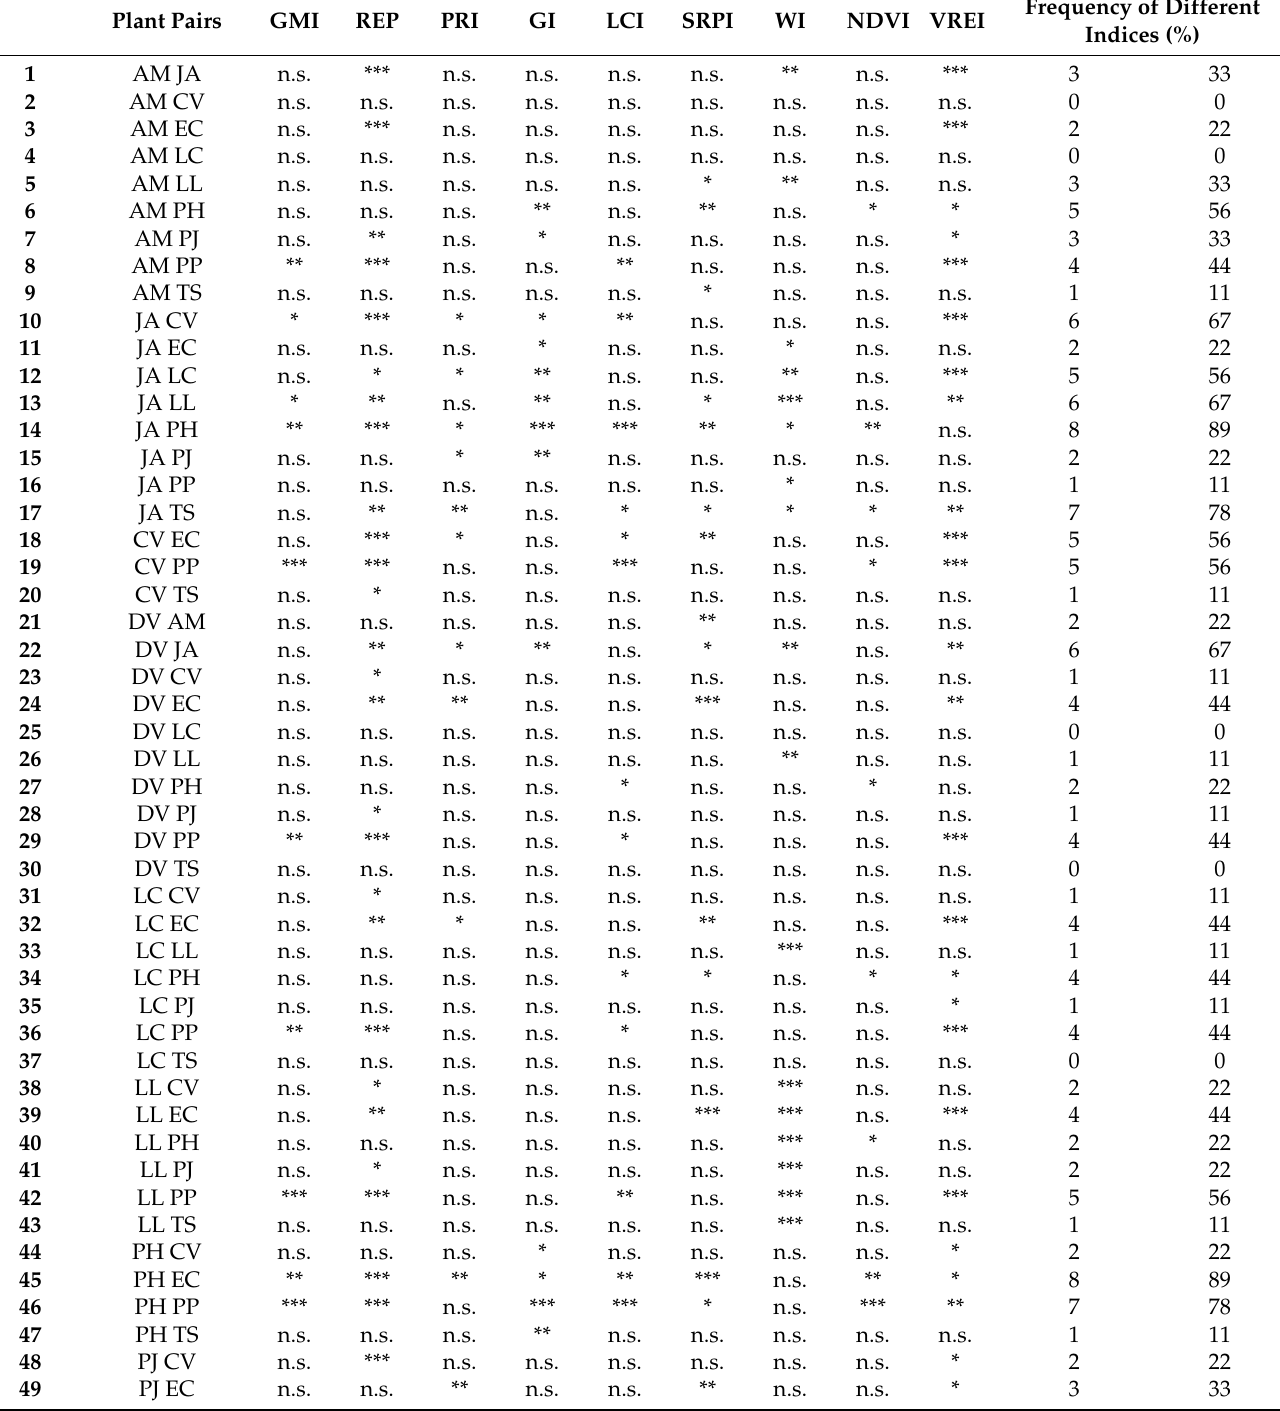
Table A1. Results of Holm–Bonferroni post hoc tests of all pairs of plant species using pair comparison plot app (significance level: * = p < 0.05, ** = p < 0.01, *** = p < 0.001, n.s = non-significant). Plant Pairs